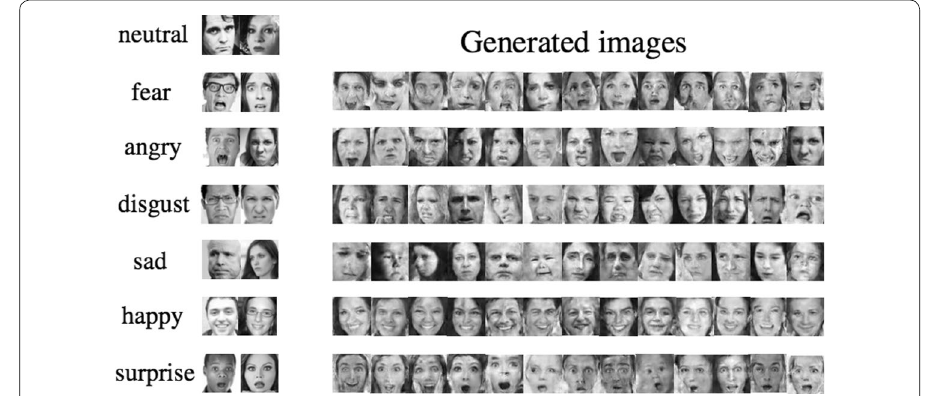
Fig. 19 Some examples of synthetic data created with CycleGANs for emotion classification